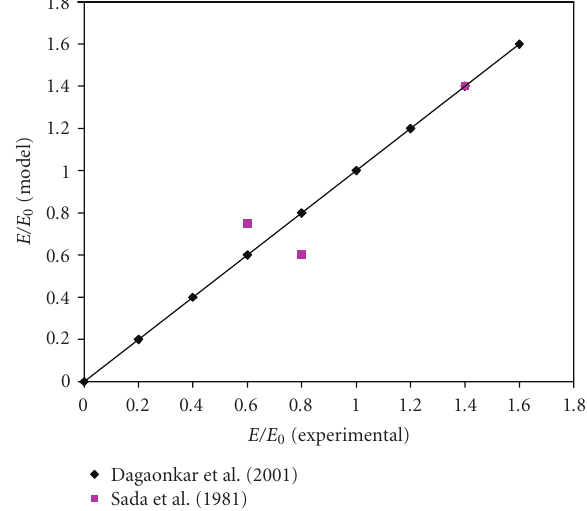
Figure 5: Comparison between experimental values available in literature and model values of the enhancement factor for the SO 2 – slurry Mg(OH) 2